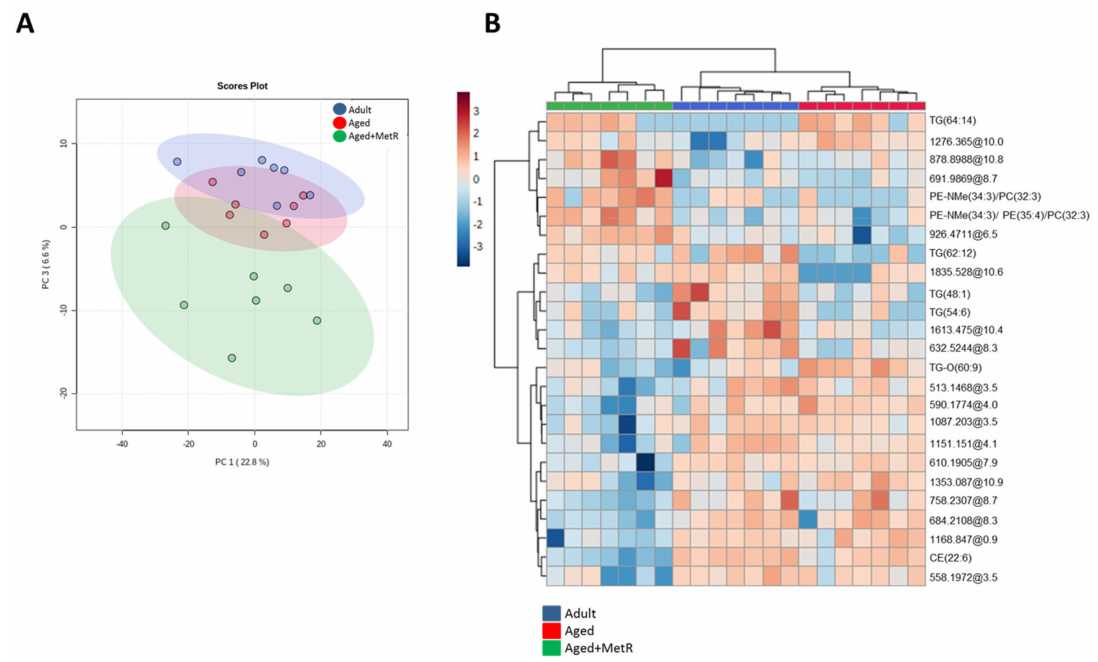
Figure 2. Multivariate analysis of the differential lipid species detected in the frontal cortex during aging and methionine restriction applied in old age. ( A ) Two-dimensional principal component analysis (PCA) for the different analyzed groups: adult, aged, and aged+MetR. ( B ) Heatmap of hierarchical clustering using the 25 lipid species with the lowest p -values. Each colored cell on the map corresponds to a relative concentration value, with samples in columns and compounds in rows. N (Adult) = 7, n (Aged) = 7, n (Aged+MetR) =